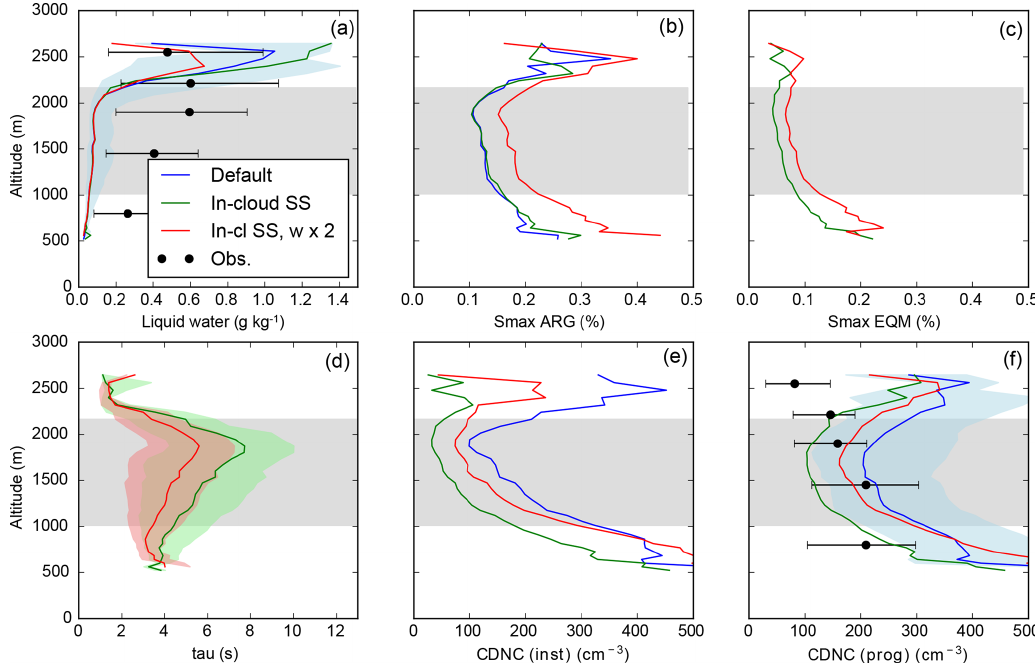
Figure 10. Liquid water content, maximum supersaturation “Smax” calculated via the ARG parameterisation and the in-cloud equilibrium “EQM”, supersaturation relaxation time “tau”, instantaneous concentration of new droplets activated “CDNC (inst)” and prognostic droplet number concentration “CDNC (prog)” at 12:00UTC on 19 August. Each plot shows the old version of the 500m resolution model, labelled “Default”; the case where the reduction of supersaturation in clouds is accounted for, “in-cloud SS”, and the cases where this reduction is accounted for and the updraught speed in the activation scheme is increased by a factor 2, “in-cl SS, w × 2”. In-cloud medians are shown (so the liquid water content is above 0.01gkg − 1 , and we divide by the cloud fraction), and except in the case of liquid water content and prognostic cloud droplet number (a, f) , the plots also only show means over grid cells where a positive water mass is condensing. The observed median liquid water content and droplet concentrations are shown as black dots in panels (a, f) . Where shown, error bars or shading indicates the interquartile range of the sampled observations of the model grid cells. The plot of the relaxation time, tau, only includes grid cells where the relaxation time is used – i.e. where the cloud fraction exceeds 0.05 and the equilibrium supersaturation in the cloudy part of the grid cell is lower than the ARG supersaturation. We also show shaded in grey the vertical band containing 95% of the total liquid water content, because otherwise the eye is drawn to the higher altitudes. Above the shaded region, there are only a few cloudy grid cells, which do not have a strong impact on the domain-mean radiative properties, because the tops of most of the clouds in the domain are at or slightly below the top of the shaded region and not above it.